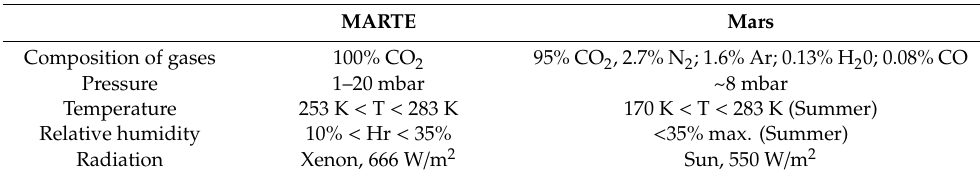
Table 1. Environmental variables in MARTE and in the red planet [15].